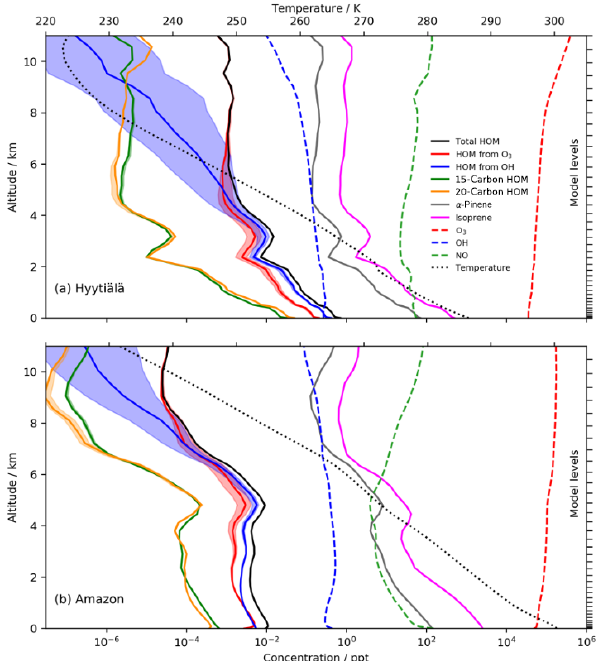
Figure 7. HOM profiles in June (14:00LT) above (a) Hyytiälä and (b) the Amazon near Manaus. Despite higher [ α -pinene], the sig- nificantly higher CS in the Amazon results in lower [HOM]. The temperature dependence (shown by the shading) is more significant at low altitude with Hyytiälä’s cooler temperatures. The Amazon’s higher isoprene /α -pinene ratio ( ∼ 20) results in greater suppres- sion of the 20-carbon accretion product than at